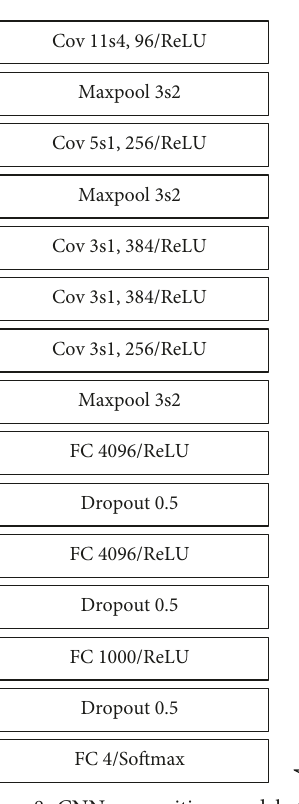
Figure 8: CNN recognition model structure.